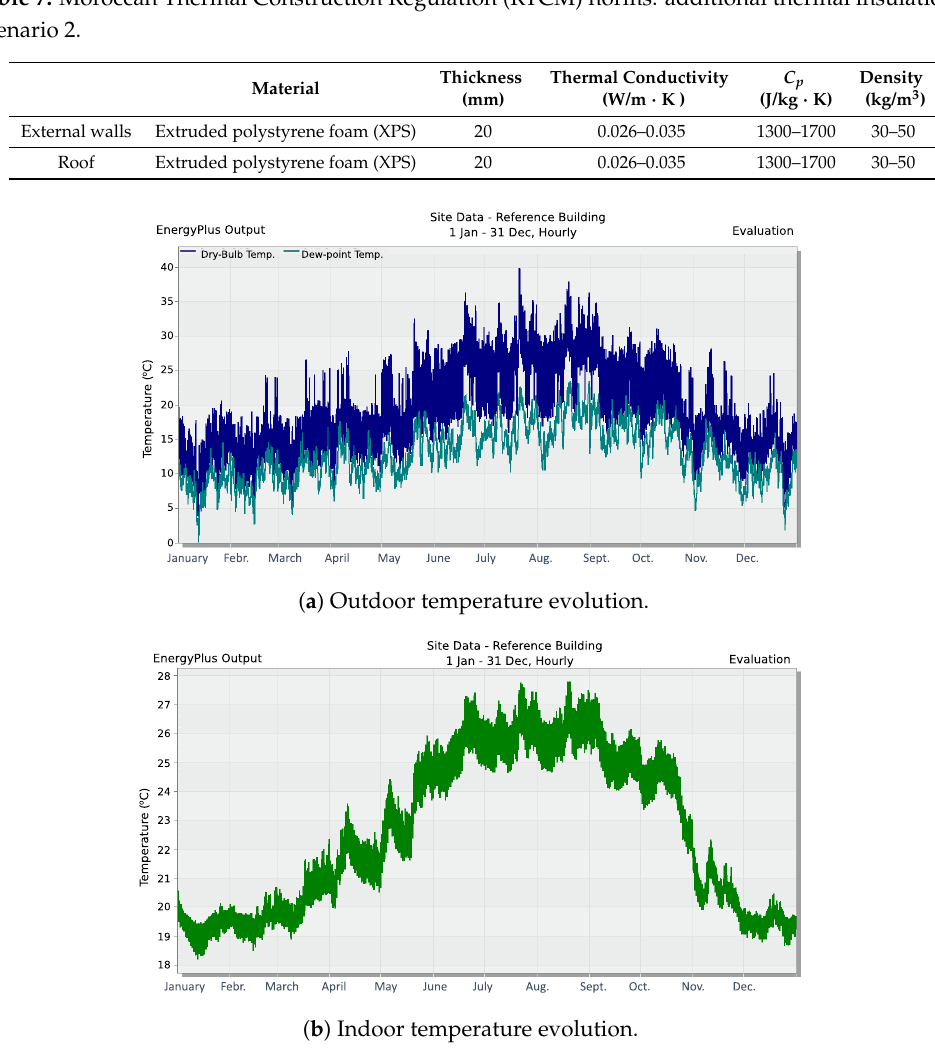
Figure 9. Temperature evolution for the reference building. Tangier (Morocco)—Scenario